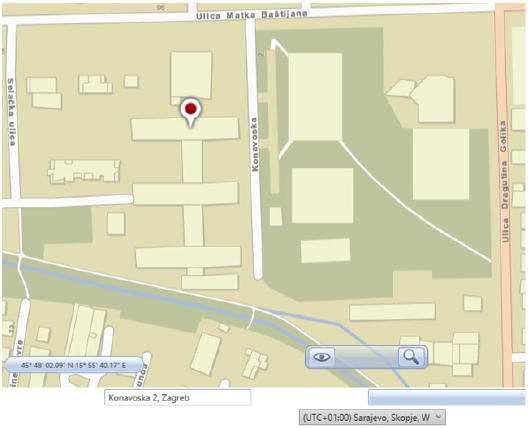
Figure 2. Selection of location and meteorological data for the observed building.